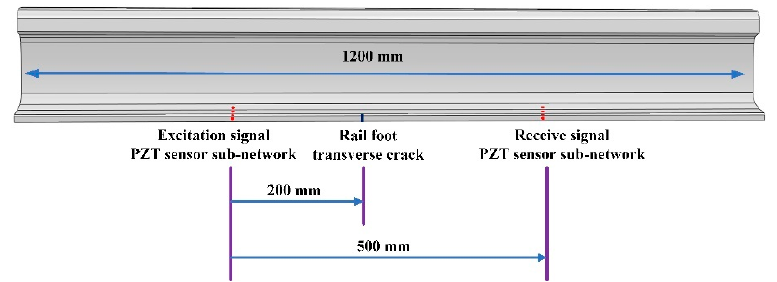
Figure 6. Schematic diagram of piezoelectric sensor array on rail bottom.